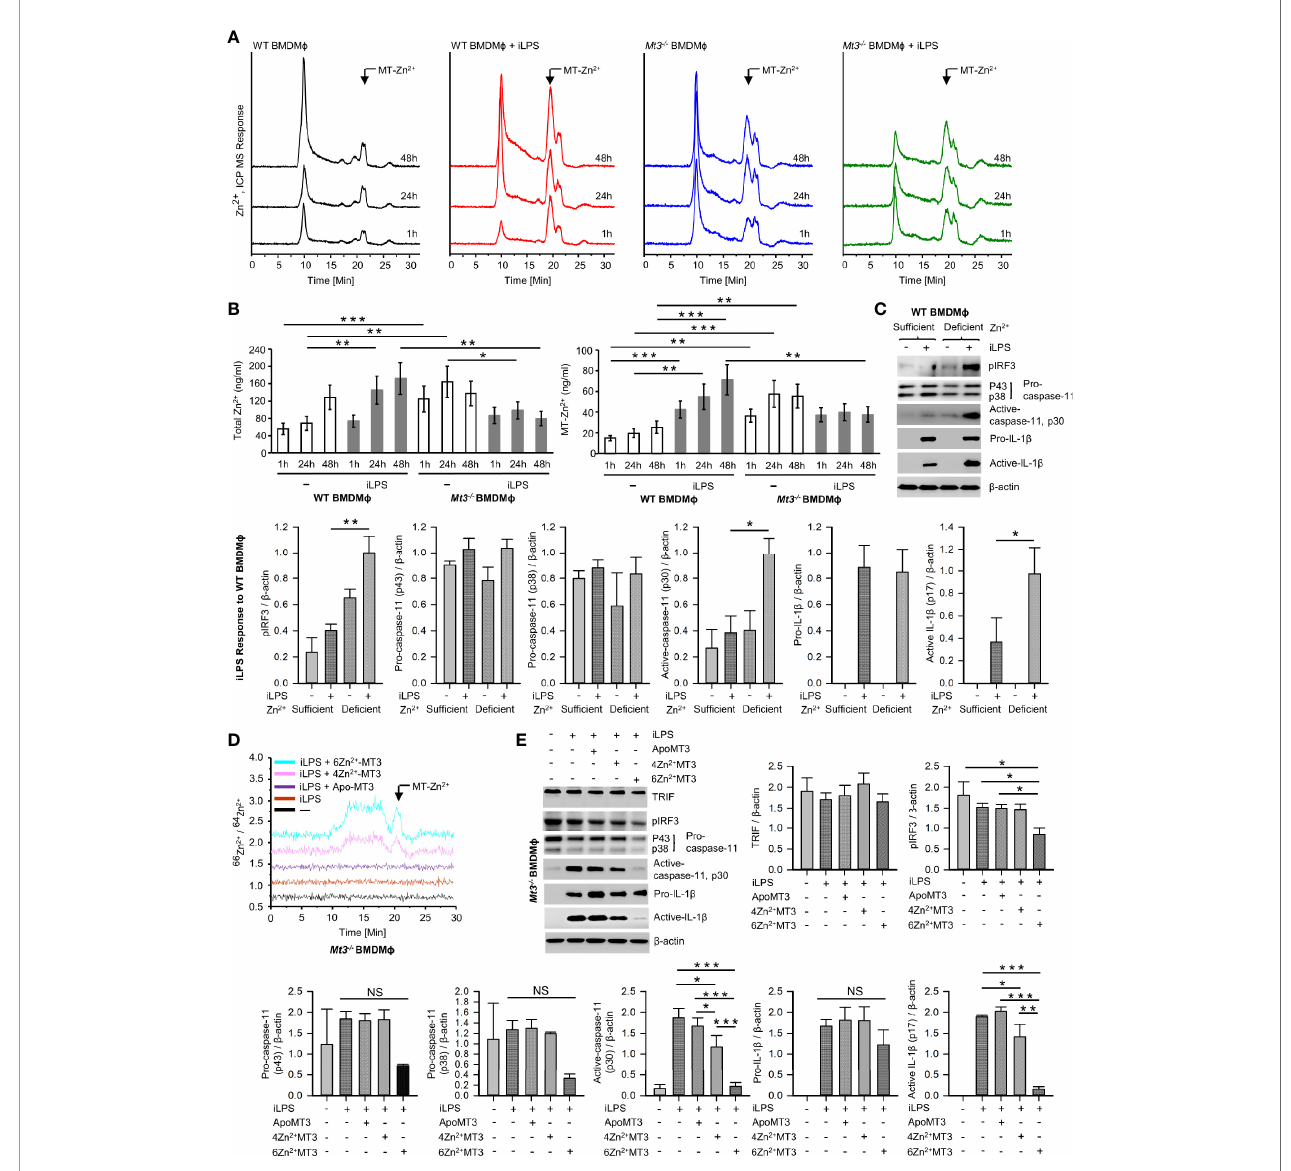
FIGURE 6 | See also Supplementary Figures S6 , 7 MT3-Zn 2+ axis drives negative regulation of the non-canonical in fl ammasome. (A) SEC-ICP-MS of WT and Mt3 -/- BMDM f exposed to vehicle or iLPS (10 ug/ml) for the indicated time points, chromatograms depict Zn 2+ distribution in cell lysates across various molecular masses, arrow indicates Zn 2+ associated with the MT-peak (18-21 min.) on the chromatogram, Y axis is off-set to allow easy comparison under the same scale. (B) Bar graphs of total Zn 2+ and MT-Zn 2+ in WT and Mt3 -/- BMDM f post iLPS (10 m g/ml) or vehicle exposure. Two-way t-test against respective BMDM f controls at each time point, 3 independent experiments, data are mean ± SD. (C) WT BMDM f treated with iLPS (10 m g/ml) or vehicle for 24h in Zn 2+ suf fi cient or Zn 2+ de fi cient Opti-MEM media, immunoblots of pIRF3, pro-caspase-11, active-caspase-11 and pro-IL-1 b in lysates and active-IL-1 b in media supernatants, one-way ANOVA, data are mean ± SEM. (D, E) Mt3 -/- BMDM f transfected with Pro-Ject ™ or Pro-Ject ™ complexed with apo-MT3, 4Zn 2+ MT3 or 6Zn 2+ MT3 and treated with iLPS (10 m g/ml) or vehicle for 24h in Zn 2+ de fi cient Opti-MEM media. (D) Chromatograms depict Zn 2+ distribution in cell lysates across various molecular masses, arrow indicates Zn 2+ signal associated with the MT-peak (18-21 min.) on the chromatogram, Y axis is off-set to allow easy comparison under the same scale. (E) Western blots of pIRF3, pro-caspase-11, active-caspase-11 and pro-IL1 b in lysates and active-IL-1 b in supernatants, 3 independent experiments, one-way ANOVA, data are mean ± SEM. *p < 0.05, **p < 0.01, ***p < 0.001; NS, not signi fi